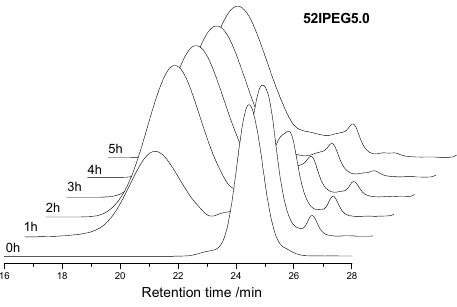
Figure 6. SEC spectra of 52IPEG5.0 with the time interval of 1 h.